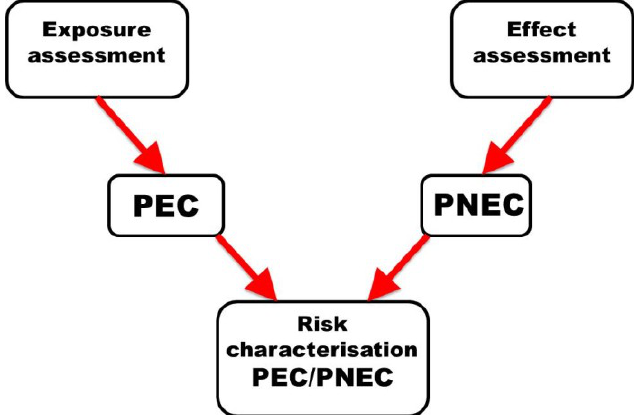
Figure 1. Simplified scheme of the procedure for ecological risk assessment. PEC, predicted environmental concentrations; PNEC, predicted no effect concentration.